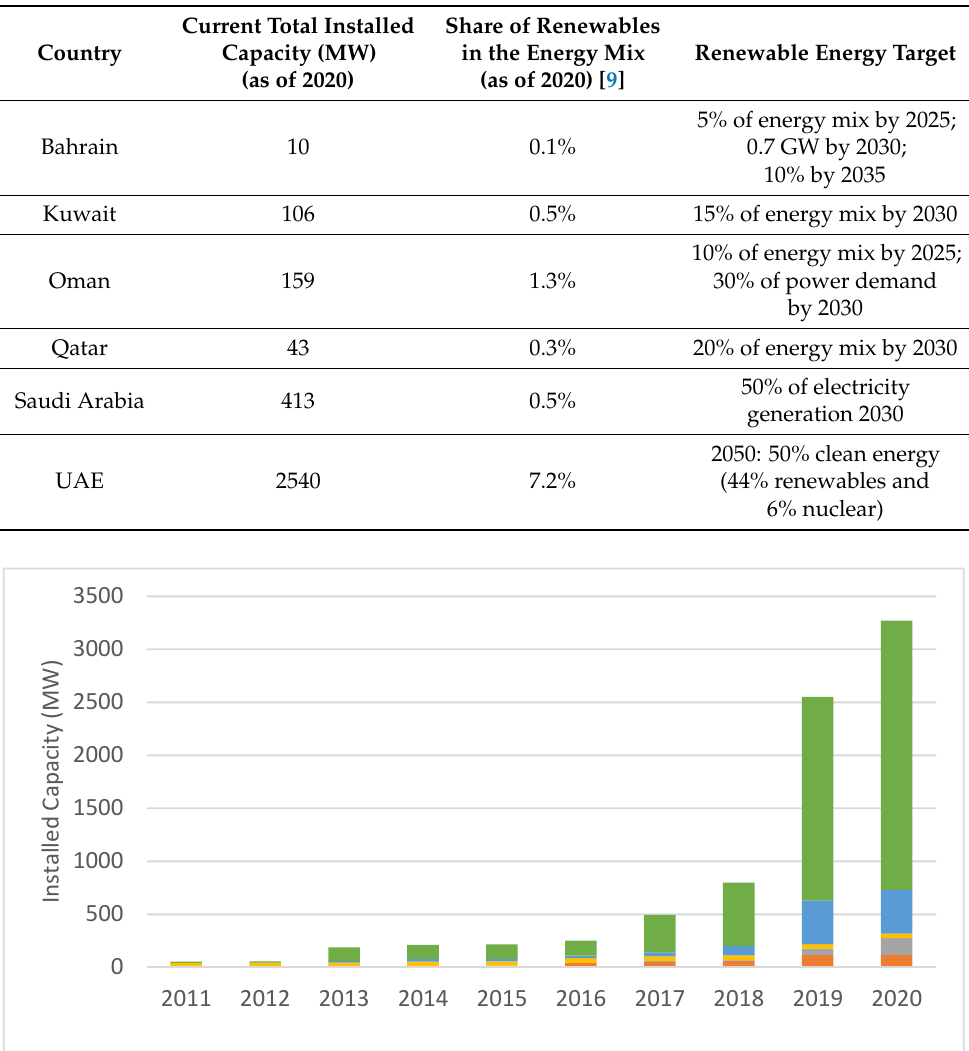
Table 1. GCC renewable energy total installed capacity, targets, and share in the energy mix.